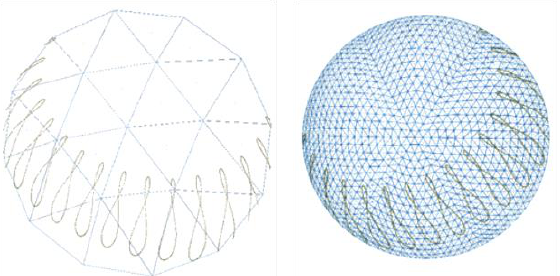
Figure 13 Equal-angle Sub Division of Sky Dome (ref)